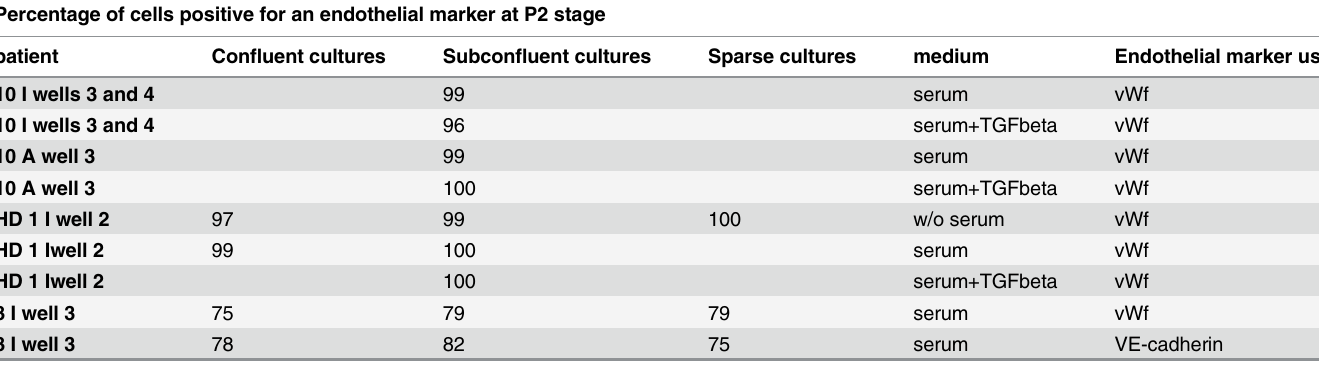
Table 2. Immuno-phenotyping of the isolated cells processed for biochemical analysis. Percentage of cells positive for an endothelial marker at P2